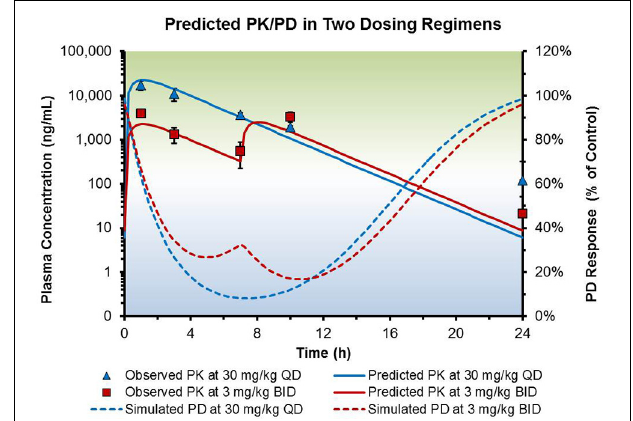
FIGURE 5 | Simulation of steady-state exposure and efficacy data of hypothetical dosing regimens in a preclinical mouse model. A drug was dosed at 30mg/kg once daily (QD) or 3mg/kg twice daily (BID) in a mouse xenograph model. Observed and predicted plasma levels were plotted with the simulated PD responses to aid selection of dose and dosing frequency in a follow-up efficacy